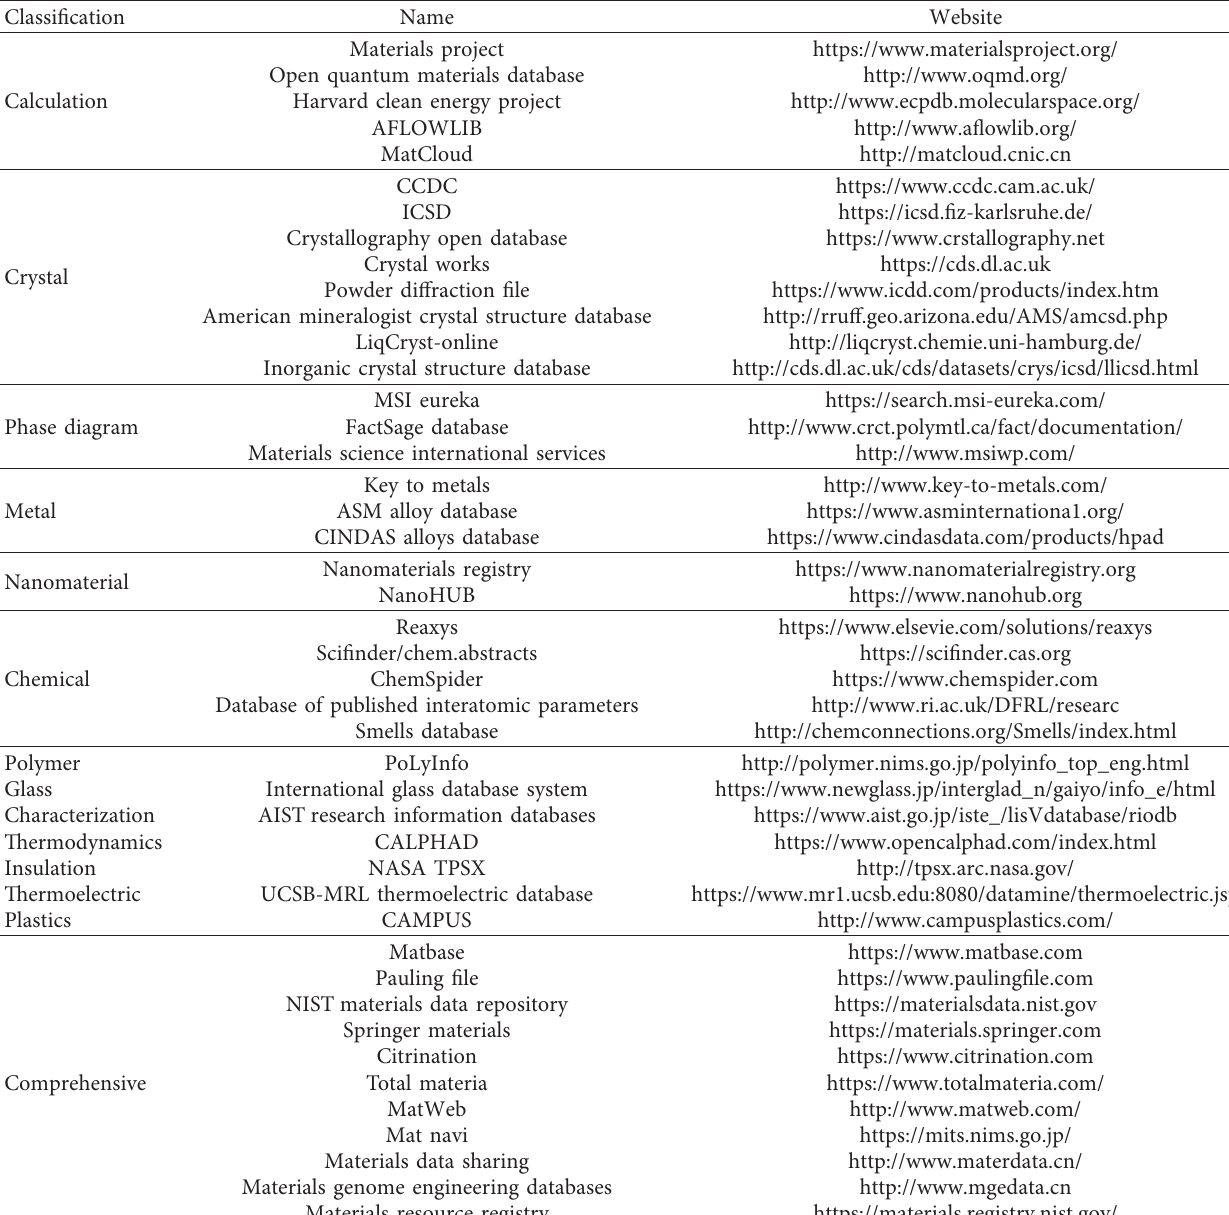
Table 1: Common materials databases and related information lists [24, 71, 72].